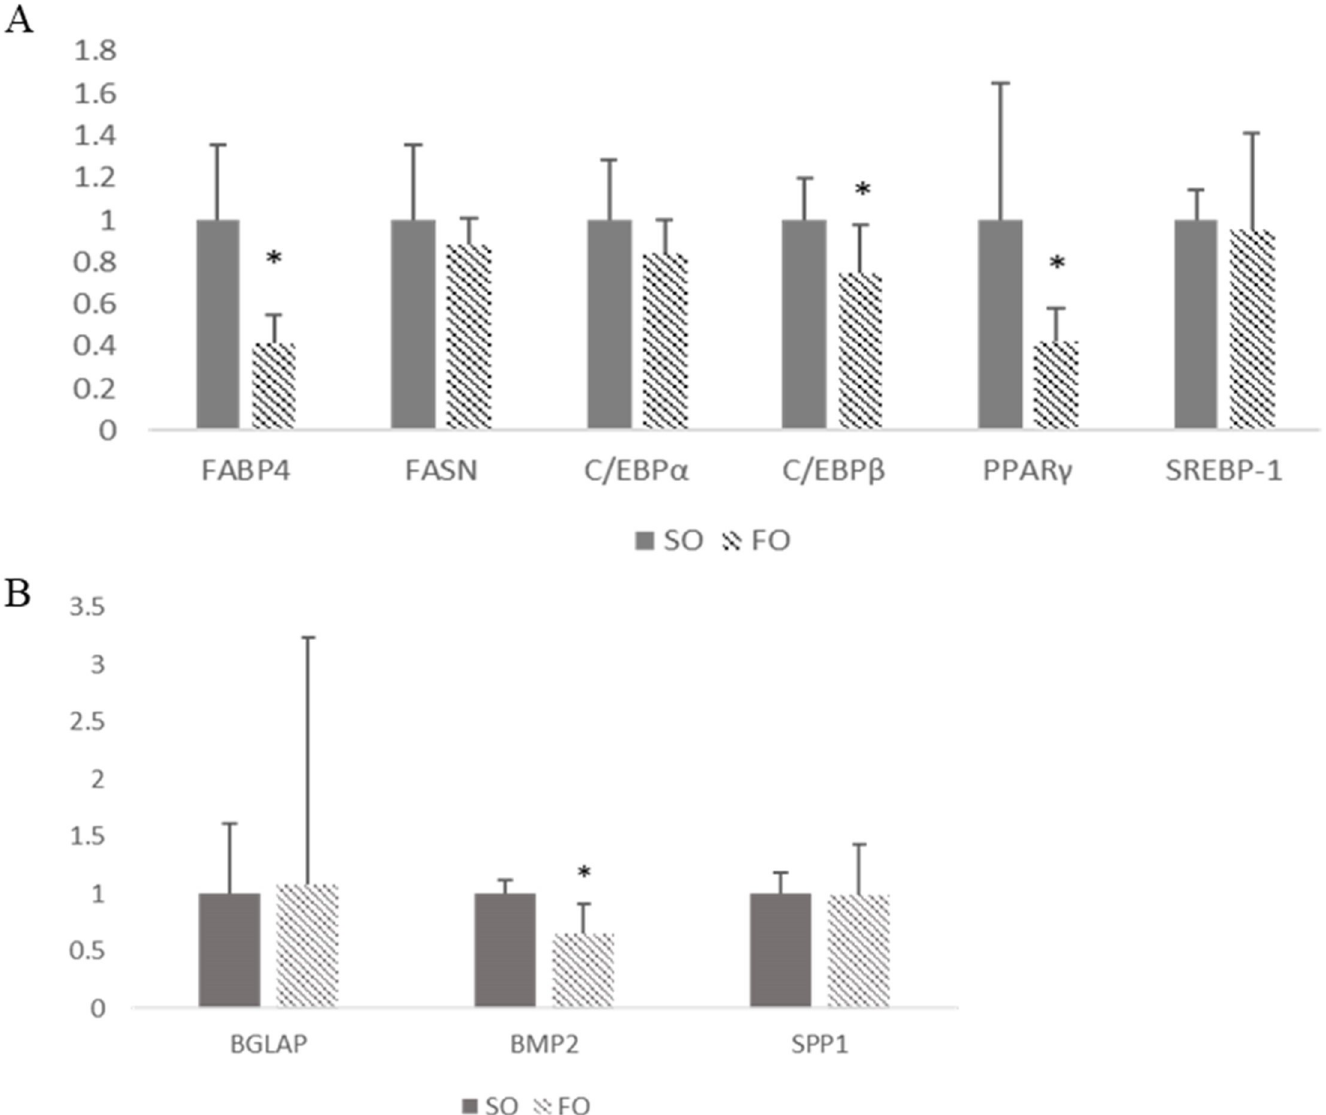
Fig 3. The relative mRNA expression of adipogenesis and osteogenesis marker genes. Maternal fish oil supplementation suppressed bone marrow adipogenesis but didn’t change osteogenesis in offspring broiler. Expression of A) adipogenesis marker genes; B) osteogenesis marker genes; The relative mRNA expressions were detected by qPCR method in SO and FO group. Total RNA from femur bone marrow from 42 day-old-broiler were collect and reversed (N = 6). Fold changes of gene expression were calculated using the ΔΔ Ct method by student’s t -test. Each experiment was repeated at least 3 times. The error bars represent SEM. � means there was a statistically significant difference between treatments, p <